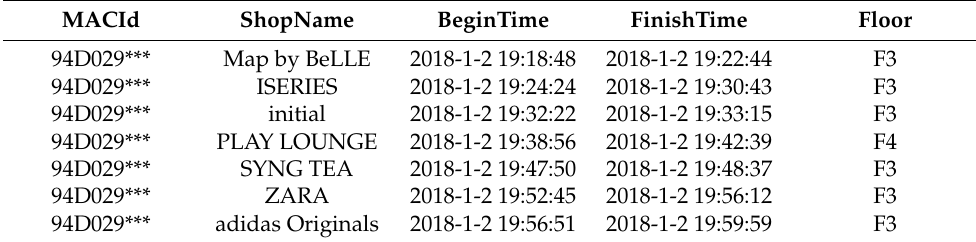
Table 4. Detailed semantic trajectory sequence data.